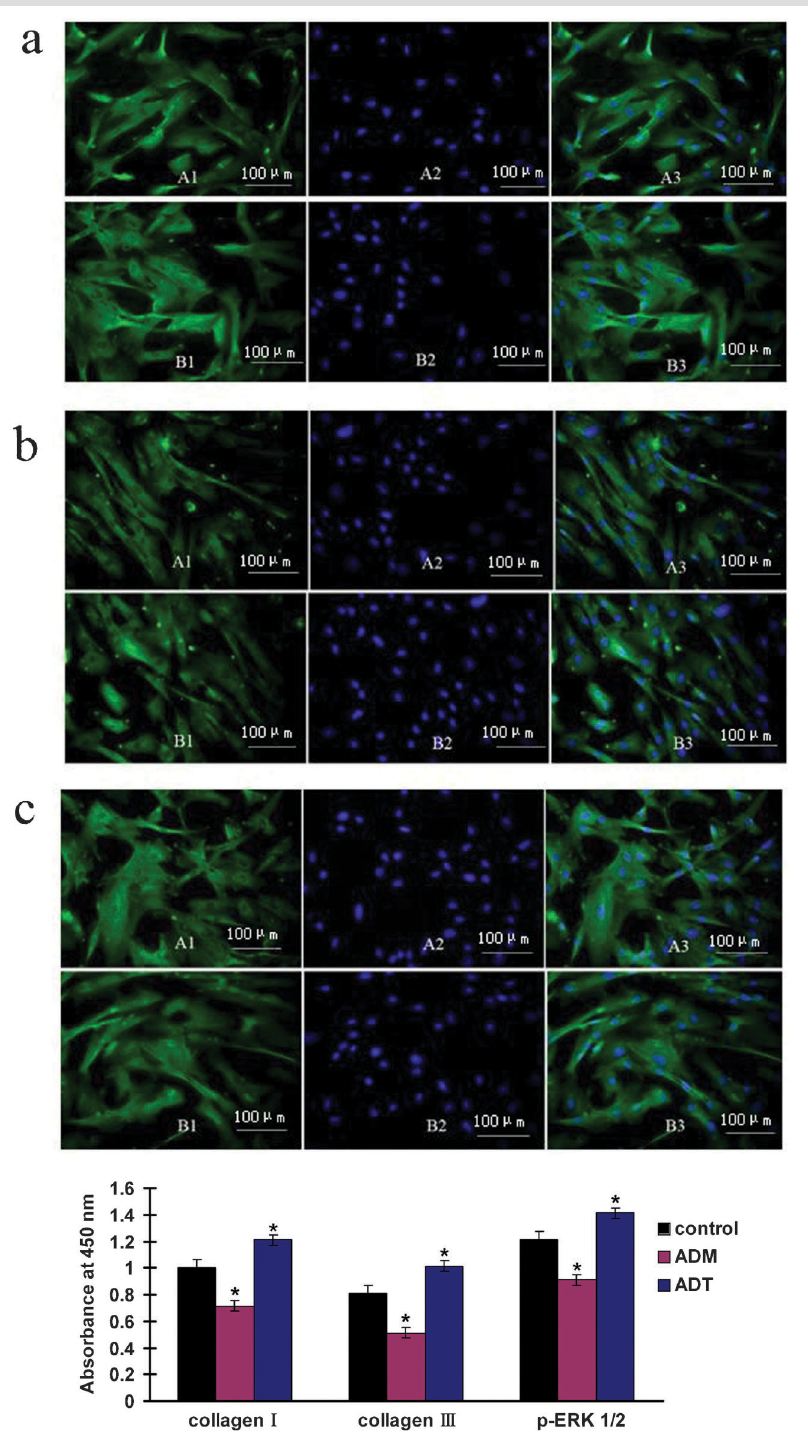
Figure 4. Protein expression of collagen I, collagen III and p-ERK1/2 in cultured PASMCs. Panels a, b, and c , Influence of 0.1 m M ADM (A1-A3) and ADT (B1-B3) on the expression of ( a ) collagen type I ( b ) collagen type III and ( c ) p-ERK1/2 in cultured PASMCs (400 6 magnification). The cell cytoplasm was stained with FITC (green; A1 and B1). The cell nuclei were stained with DAPI (blue; A2 and B2). A3 and B3 represent the overlapped images of A1 merged with A2 and B1 merged with B2, respectively. Bottom panel , Summary data showed the influence of 0.1 m M ADM and ADT on the expression of collagen I, collagen III, and p-ERK1/2 in cultured PASMCs by immunofluorescence. PASMCs: pulmonary arterial smooth muscle cells; ADM: adrenomedullin; ADT: adrenotensin. Data are reported as mean±SE absorbance for n=10 rats per group. *P , 0.05 vs control (one-way